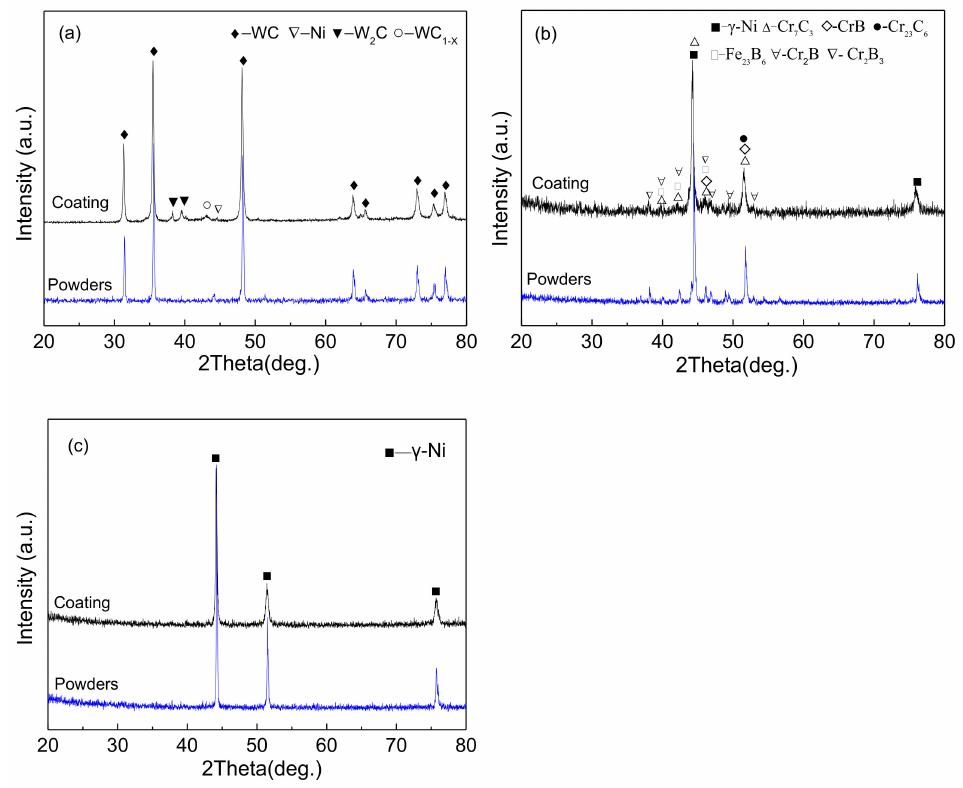
Figure 4. XRD patterns of the powders and coatings: ( a ) WC-10Ni; ( b ) Ni45; ( c )